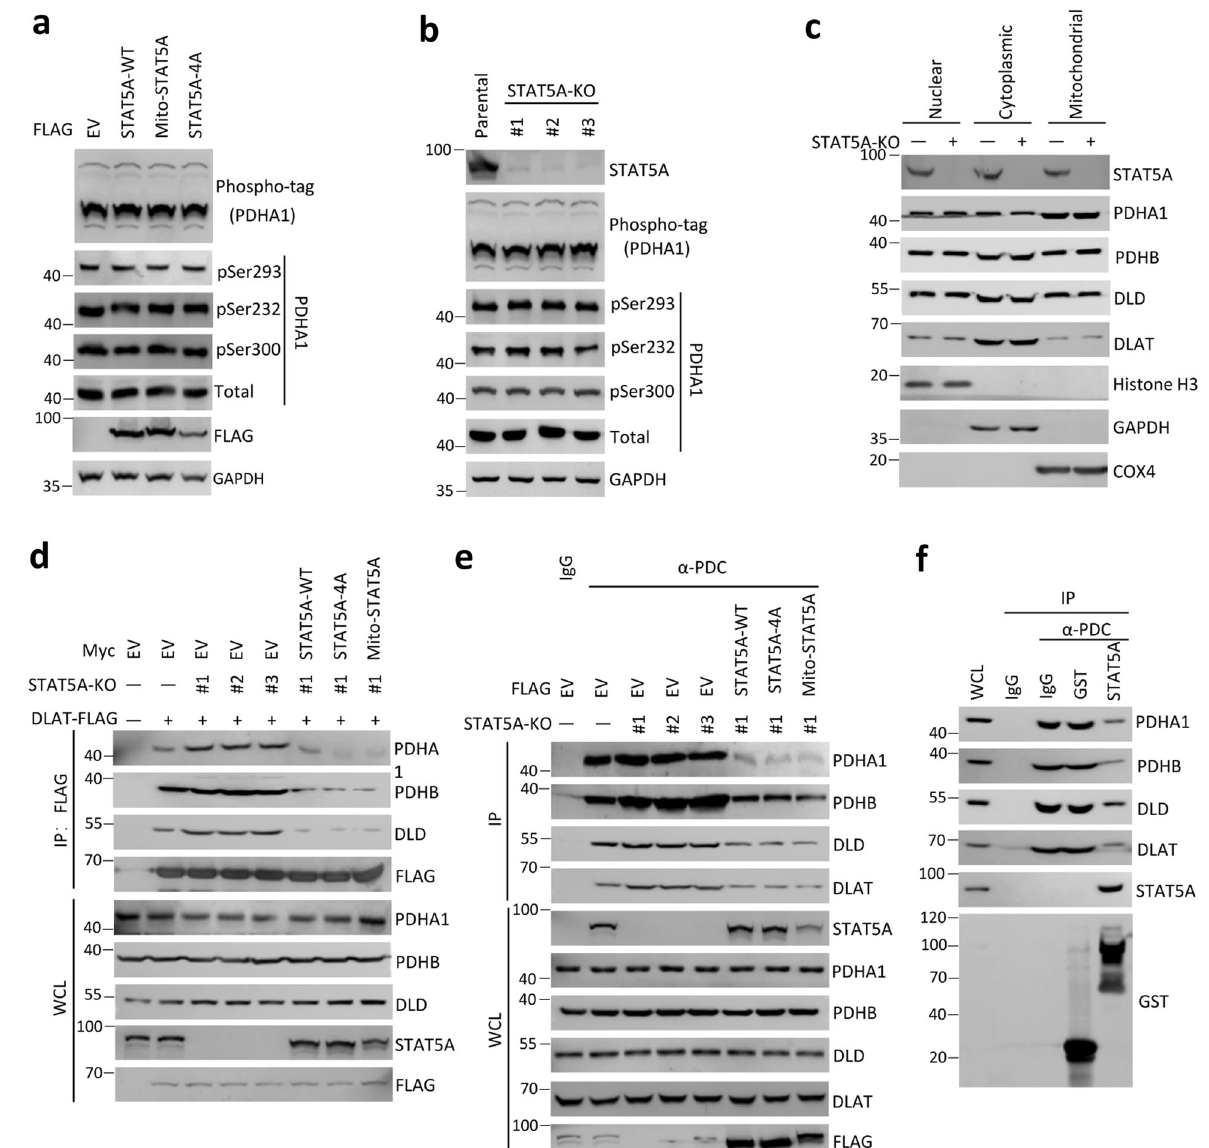
Fig. 4 Mitochondrial STAT5A suppresses PDC formation. a HeLa cells were stably transfected with indicated expression vectors. The WCL were immunoblotted with indicated antibodies. The phosphorylated level of PDHA1 (p-PDHA1) was detected by phos-tag SDS-PAGE using an anti-PDHA1 antibody. b Immunoblots of the indicated proteins in WCL from parental or STAT5A-KO HeLa cells using CRISPR/Cas9 methods. The phosphorylated level of PDHA1 (p-PDHA1) was detected by The WCL were immunoblotted with indicated antibodies. Phos-tag SDS-PAGE was performed using an anti-PDHA1 antibody. Parental HeLa cells were used as the control. c The nuclear, cytoplasmic, and mitochondrial fractions from parental and STAT5A-KO HeLa cells. The fractionated proteins were immunoblotted with indicated antibodies. d STAT5A-KO HeLa cells were stably transfected with indicated expression vectors. Then, the cells were transiently transfected with expression vectors encoding DLAT-FLAG. WCL were immunoprecipitated with anti-FLAG antibody, and the immunoprecipitated proteins were immunoblotted with indicated antibodies. e STAT5A-KO HeLa cells were transfected with indicated expression vectors. Cell lysates were immunoprecipitated with anti-PDC immunocapture antibody, and the proteins were immunoblotted with indicated antibodies. IgG was used as a negative control for Immunoprecipitation. f The intact PDC was immunoprecipitated from HeLa cells by anti-PDC immunocapture antibody and then incubated with the indicated recombinant proteins (GST or GST-STAT5A, 2 μ g) for 12 h. Bound materials and recombinant proteins were detected by The same amount of FLAG-STAT5A in three separated fractions were subjected to co-IP assays and detected by immunoblot. The method is as follows: immunoblot was used to quantify the STAT5A proteins in the three fractions. The amounts of STAT5A proteins in the mitochondrial fraction were taken as a reference, and the amounts of STAT5A protein in the nuclear fraction or cytoplasmic fraction were adjusted to be consistent with that in the mitochondrial fraction.